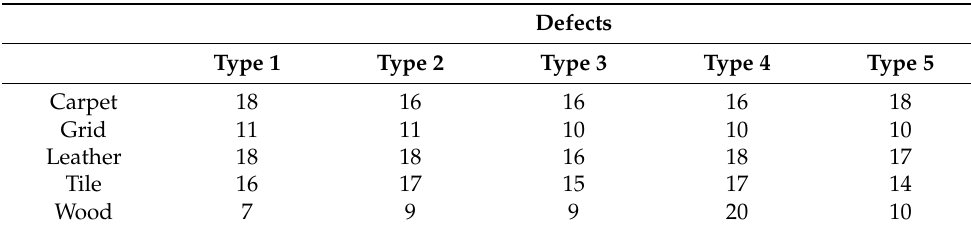
Figure 4. Basic textures used in this research work. Table 3. Number of images for each texture.